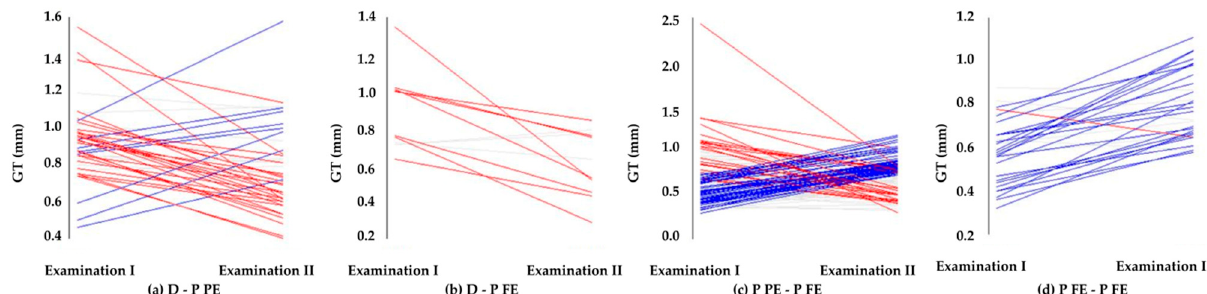
Figure 2. Gingival thickness (GT) changes noticed after ( a ) the replacement of a deciduous tooth (D) with a permanent one partially erupted (P PE), ( b ) after the replacement of a deciduous tooth (D) with a permanent one fully erupted (P FE), ( c ) during eruption (P PE–P FE) and ( d ) after complete eruption (P FE–P FE).